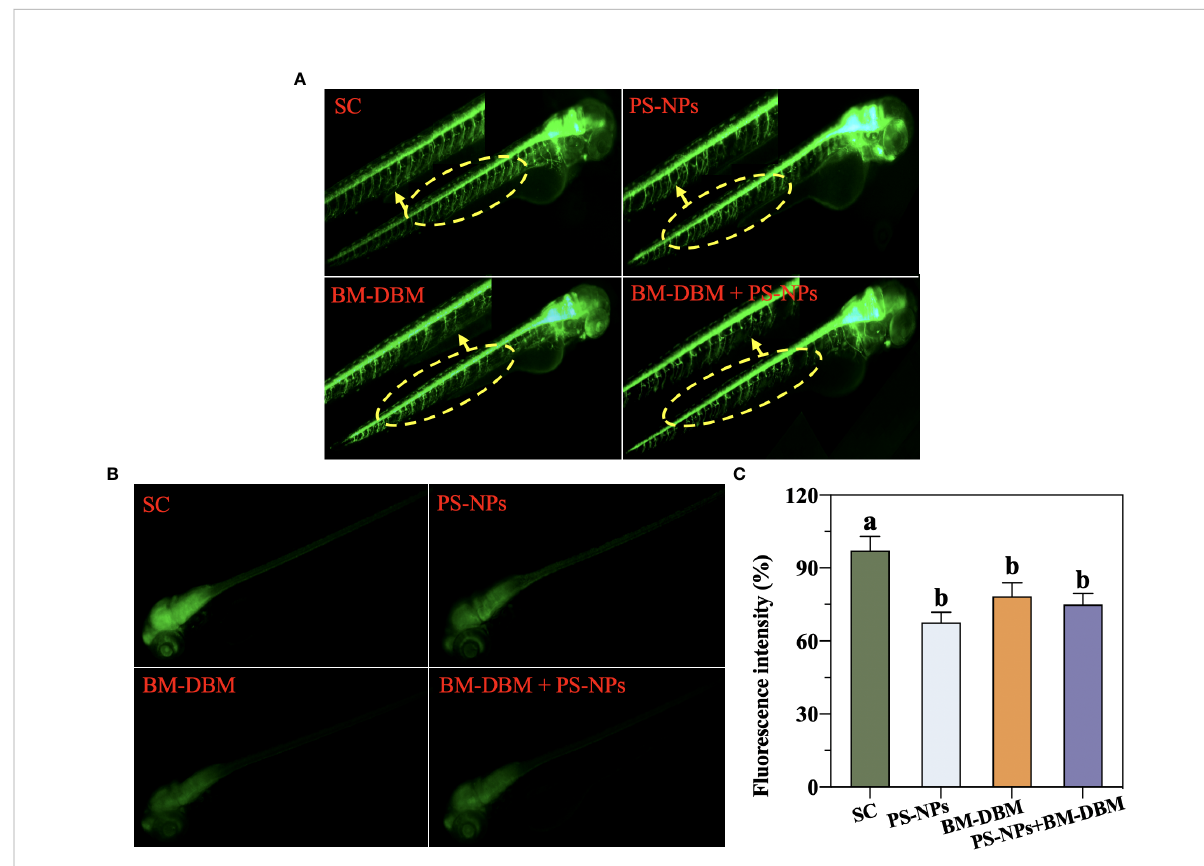
FIGURE 4 Development of (A) motor neurons and (B, C) neurons in 72 hpf larvae under BM-BDM and PS-NPs exposure conditions alone or in combination. SC represents the solvent control group. Different letters represent signi fi cant differences (P <